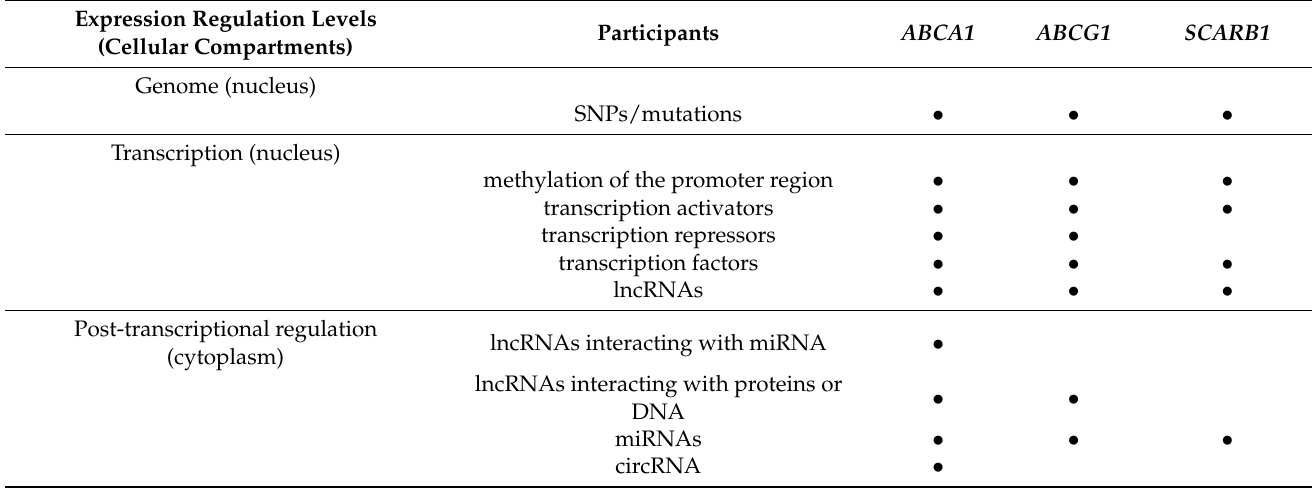
Table 1. Expression regulation levels of three cholesterol transporter genes in different cell compartments known to influence their function. Expression Regulation